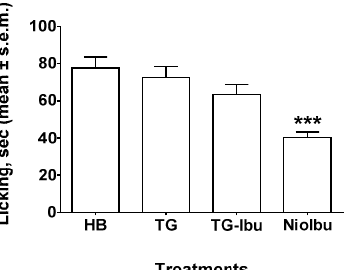
Figure 4. Effects of Hepes buffer (HB), the unstructured surfactant formulation (TG), the unstructured surfactant formulation with the same Ibuprofen (IBU) concentration (TG-Ibu), and TW20-Gly loaded with IBU (NioIbu) on the time spent licking the capsaicin-injected paw. Samples were injected subcutaneously in the dorsal surface of the hind paw 120 min before capsaicin injection. *** is for P < 0.001 versus TG. N = 10.